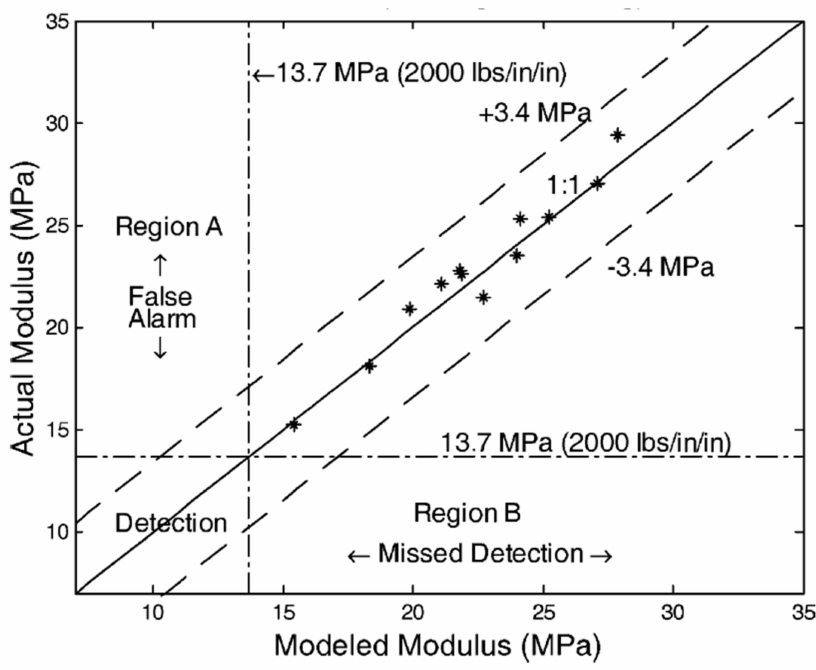
Figure 3. Comparison of estimated and measured rack modulus (figure reproduced from